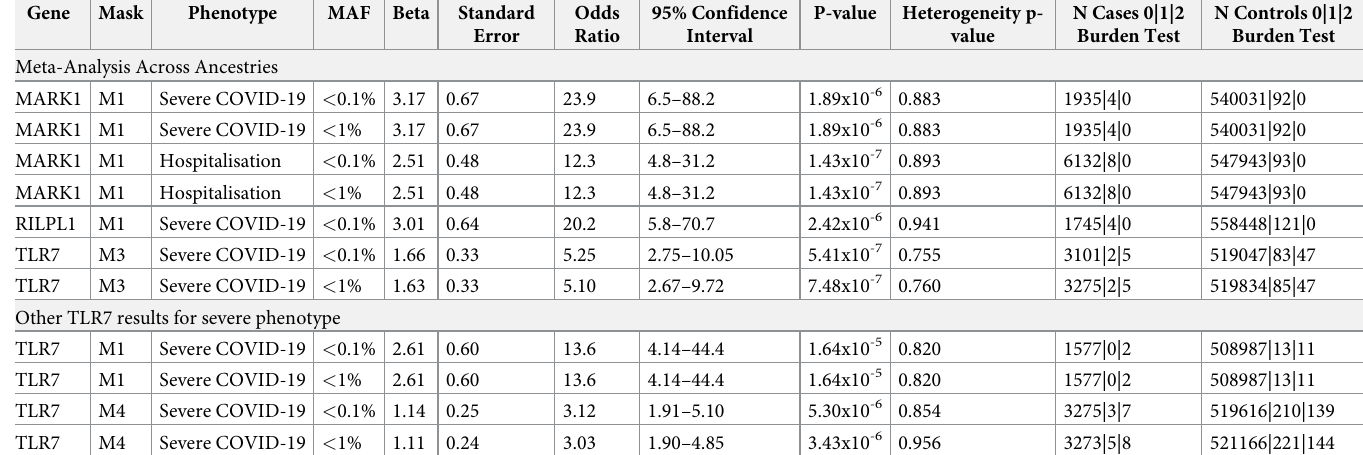
Table 1. Exome-wide significant findings, as well as other TLR7 results (for the severe phenotype only). Note that for Masks M1, all deleterious variants had a MAF < 0.1%, and hence both burden tests (MAF < 1% and 0.1%) gave the same results. Full results available in S4